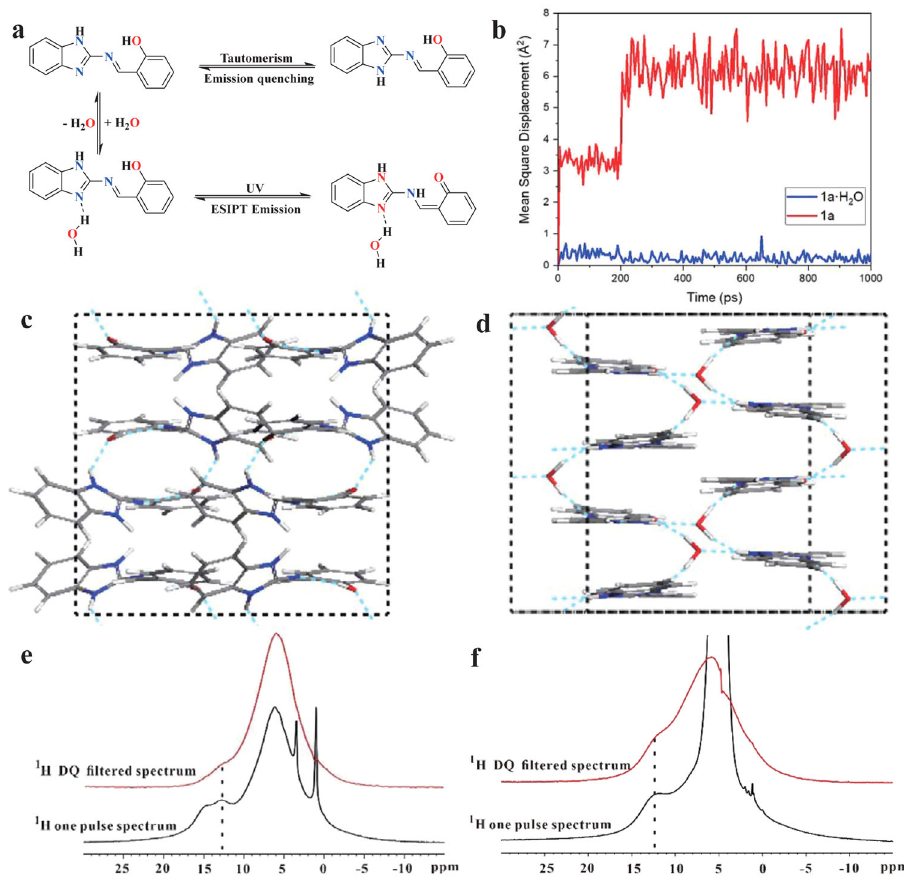
Fig. 4 Proposed activation of emission mechanism. a Proposed activation of single-molecule emission mechanism for 1a·H 2 O ; b mean square displacement of 1a and 1a·H 2 O microcrystals during 1-ns molecular dynamics simulation; optimised molecular crystal structures of c 1a and d 1a·H 2 O single crystals at the fi nal step (sky-blue dotted lines represent the hydrogen bond network); solid-state 1 H NMR spectra of e 1a and f 1a·H 2 O . 1 H double quantum fi ltered (DQ- fi ltered) spectra (in red) were recorded for comparison with 1 H one-pulse spectra (in black), where signals of protons with high local mobility were fi